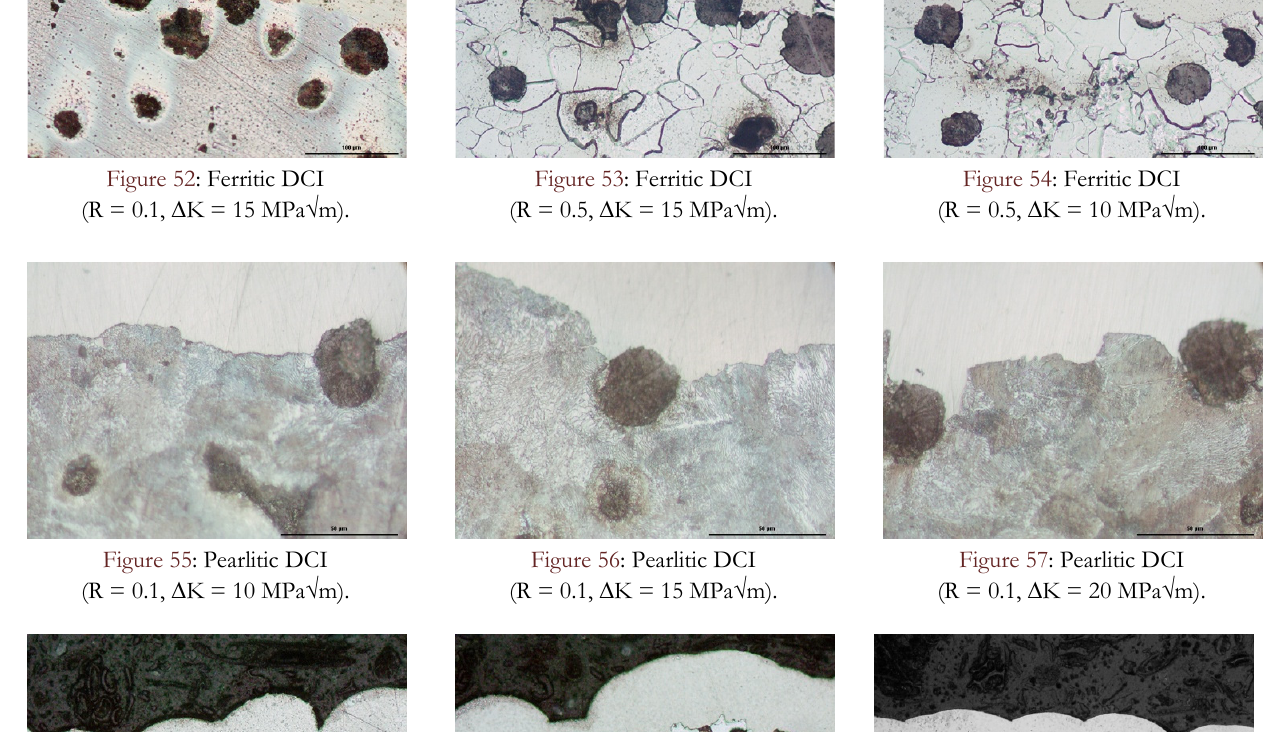
Figure 55: Pearlitic DCI (R = 0.1,  K = 10 MPa √ m).